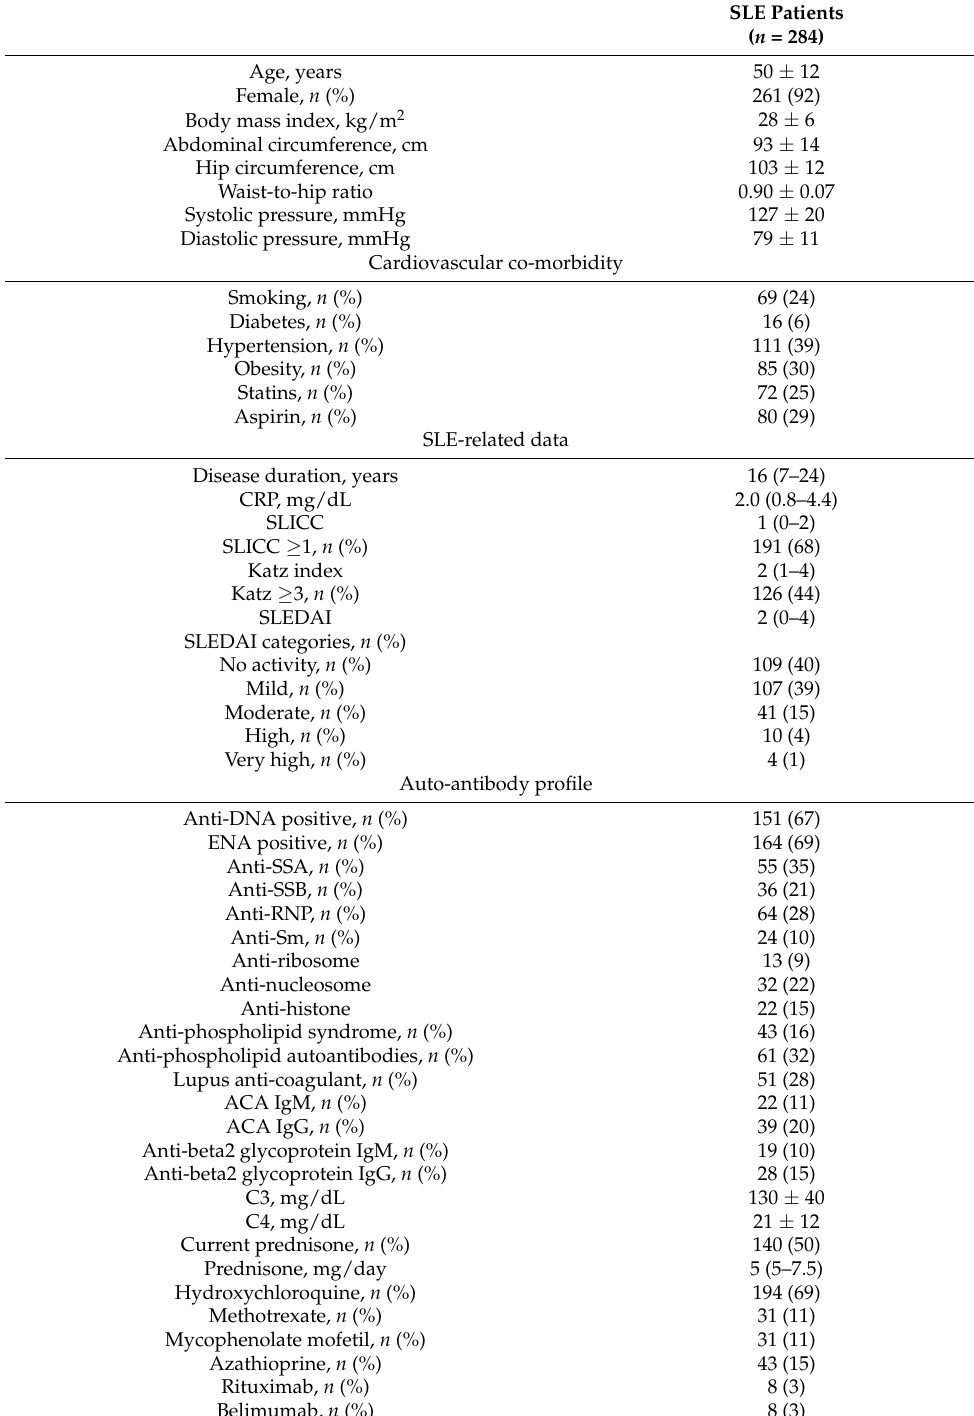
Table 1. Characteristics of the SLE